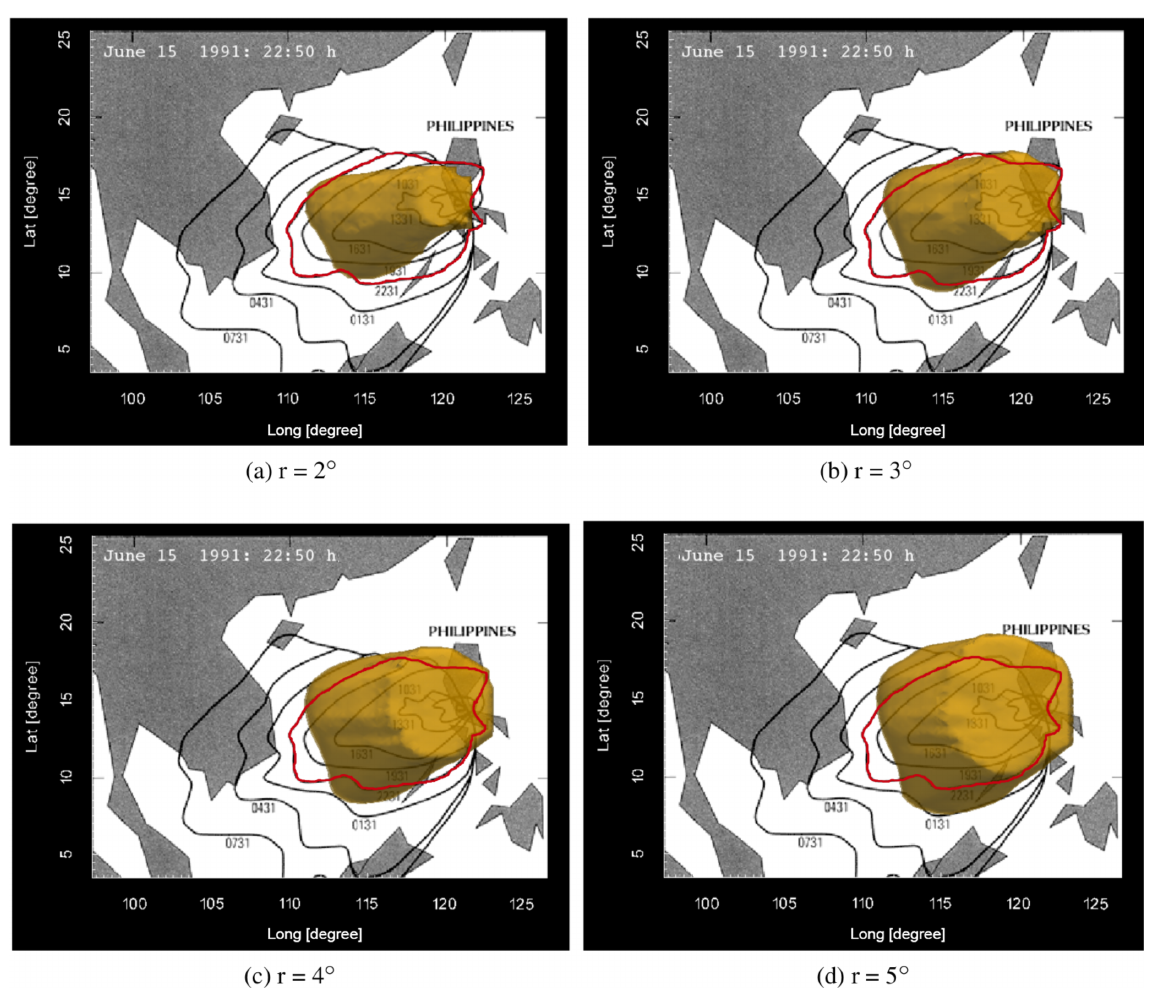
Figure 9. The modeled ash cloud on 15 June 22:30 with an initial radius of 2, 3, 4 and 5 ◦ and the outer edge of the observed umbrella cloud in 3h intervals (observed outlines from Lynch and Stephens, 1996). The modeled ash cloud is displayed for 15 June